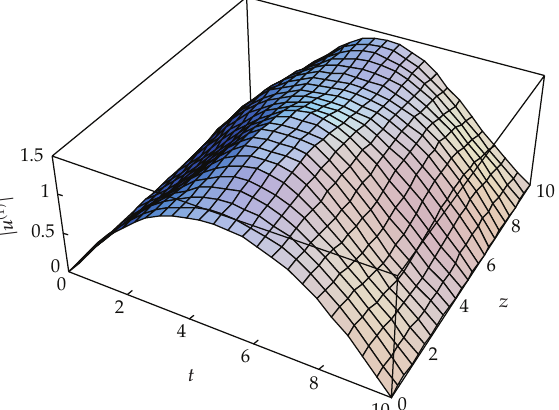
Figure 34: The first-order approximation of | u (cid:3) 1 (cid:4) | at α (cid:8) 1, T (cid:8) 10, γ (cid:8) 0, ε (cid:8) 01 with considering only one term in the series (cid:3) M (cid:8) 1 (cid:4)